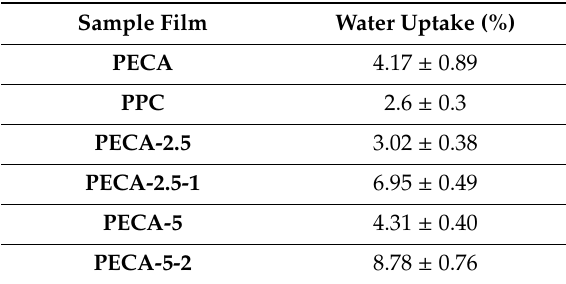
Table 3. Water uptake values of all PECA–PPC blends under 100% of relative humidity (RH). All results were expressed as mean ± SME of three